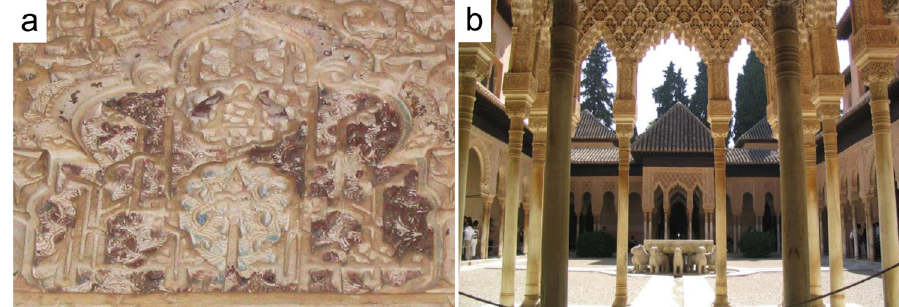
Fig. 1 Altered cinnabar paint at the Alhambra palaces (Granada, Spain). a “ Yesería ” (plasterwork) with rests of altered cinnabar paint showing a dull dark-red color found on one of the capitals of the “ Patio de los Leones ” ( b